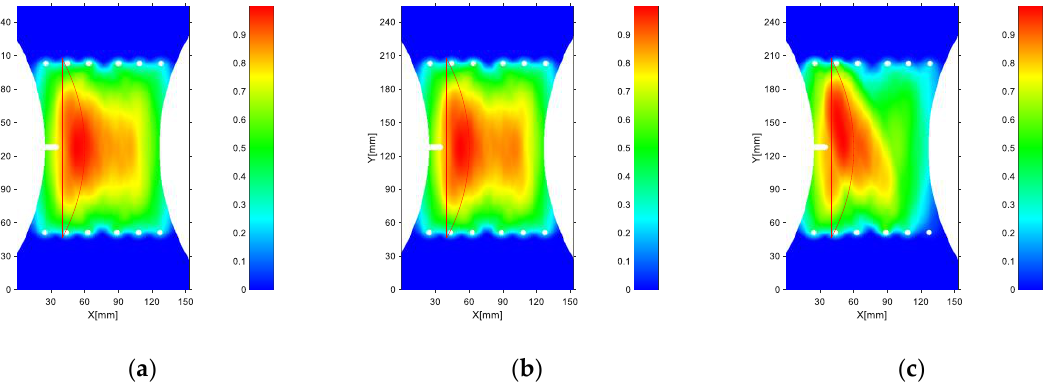
Figure 20. Imaging results with different damage factors at a signal-to-noise ratio of 3 dB: ( a ) energy damage factor; ( b ) cross-correlation damage factor; ( c ) sparse representation damage factor.